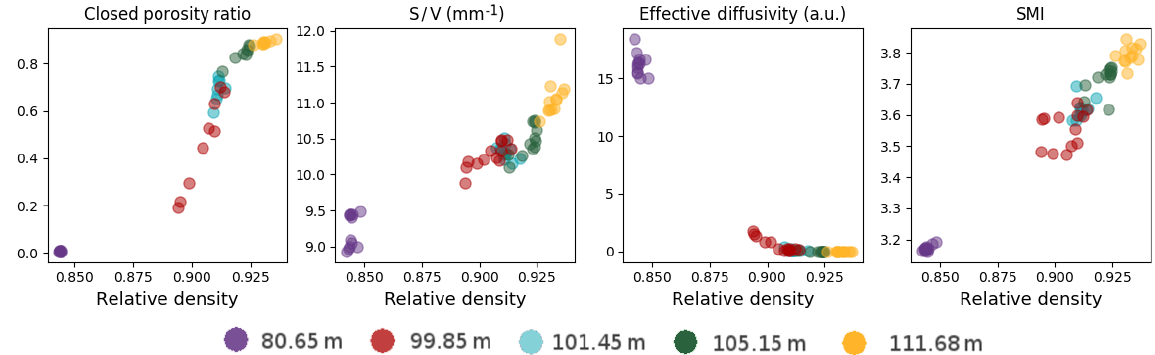
Figure 6. Closed porosity ratio and morphology indicators against relative density: closed porosity ratio, S / V ratio, effective diffusivity, and structural model index. Each color corresponds to the depth where the firn samples were taken and covers 10cm in the firn